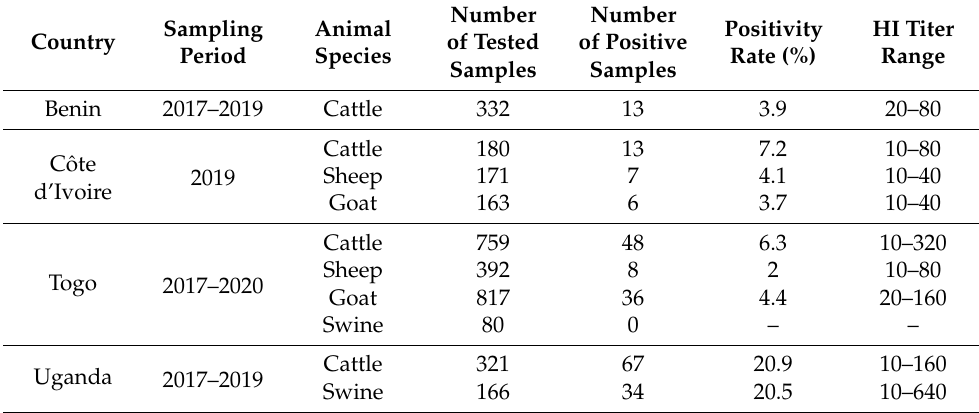
Table 1. Seropositivity rates of influenza D virus (IDV) in cattle, sheep, goat and swine in four countries of West and East